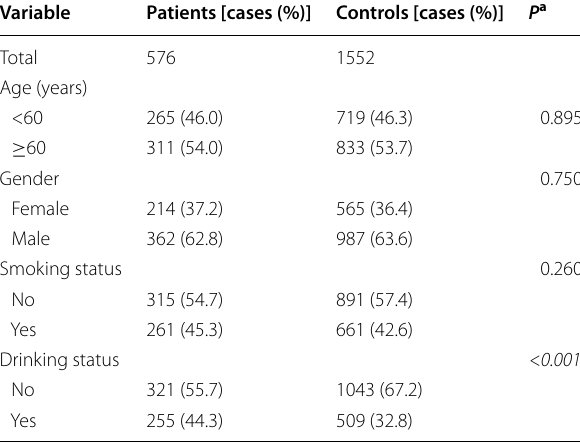
Italic value indicate significance of p value ( p < 0.05)